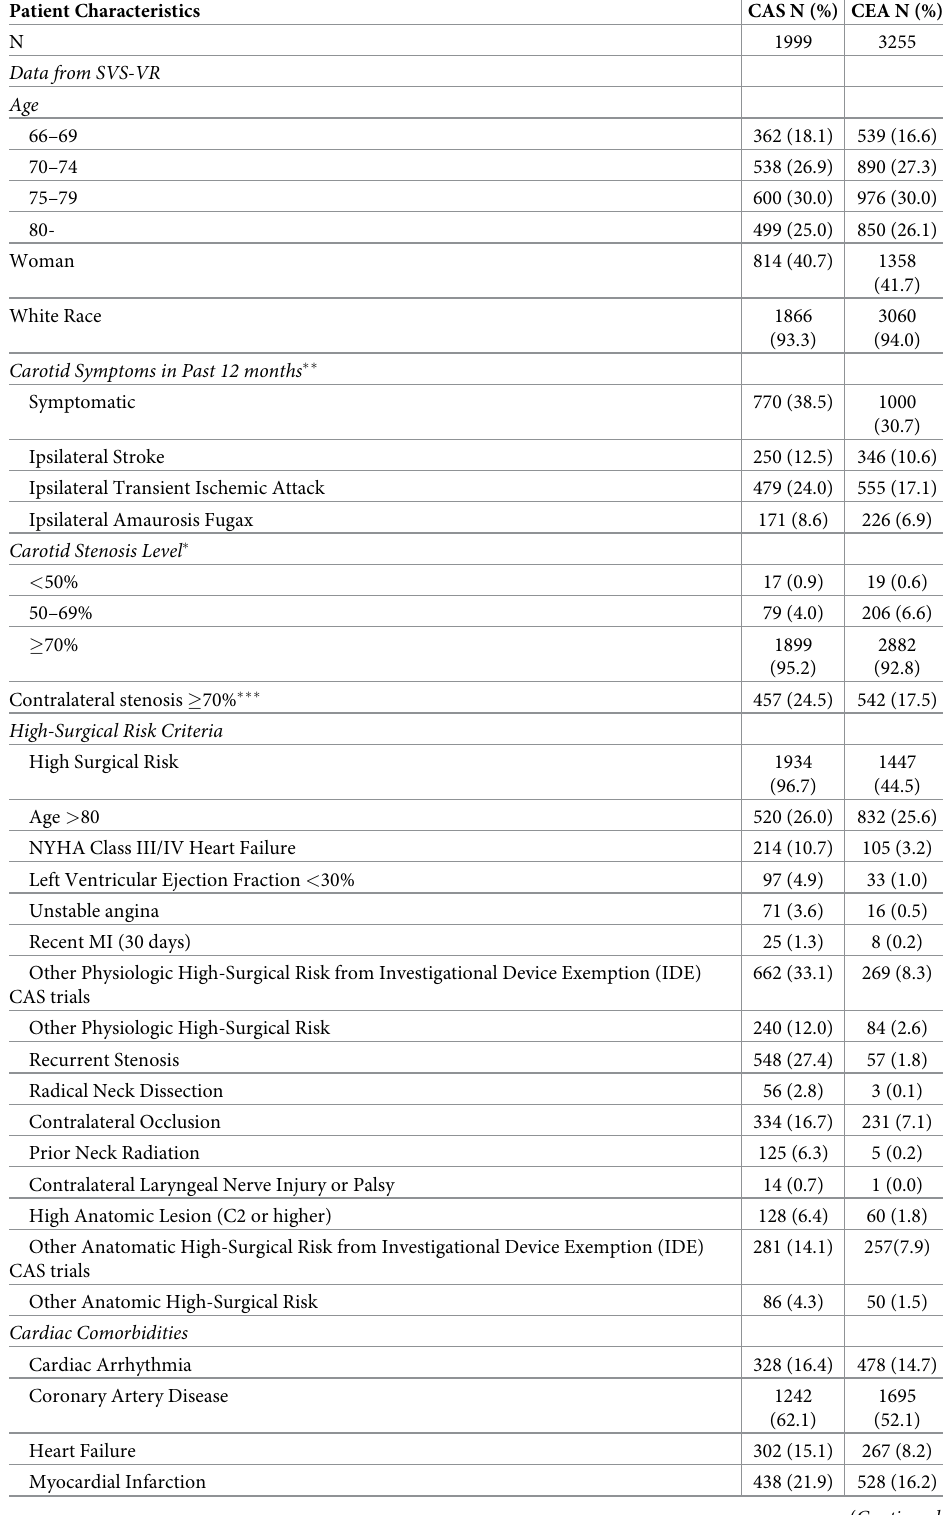
Table 1. Selected patient characteristics at baseline, by